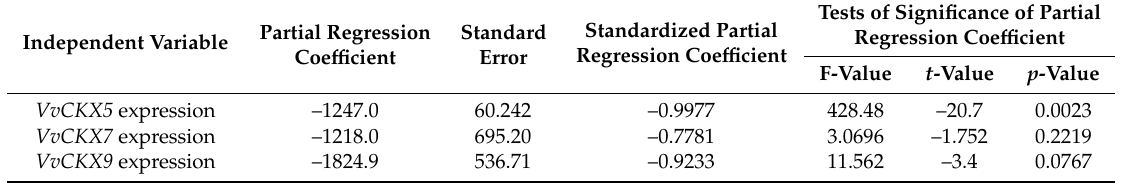
Table1. Simplelinearregressionanalysis: berrynumberversus VvCKX expressioninjuvenileinflorescence.